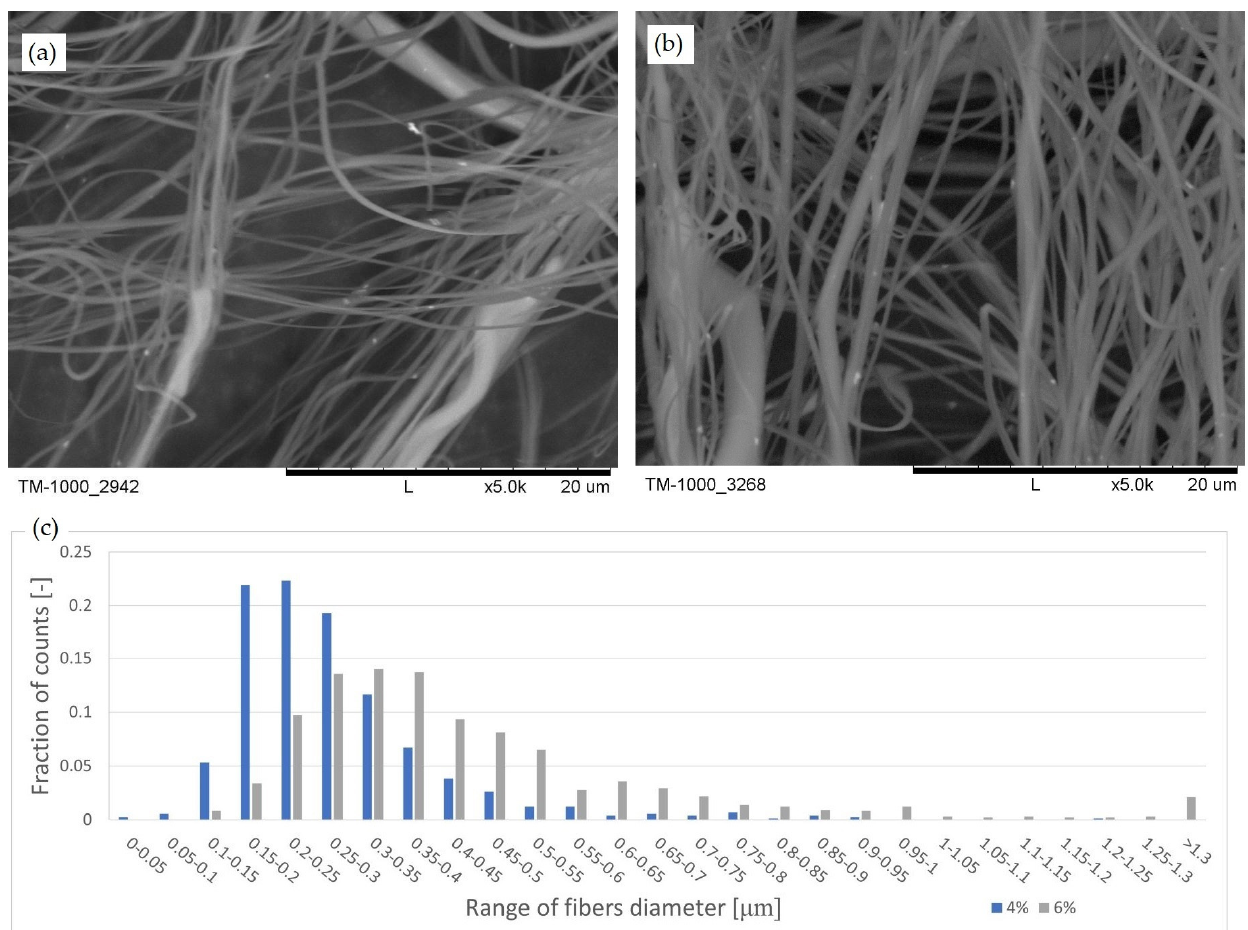
Figure 6. Fibers produced at a flow rate of 0.4 mL/min and air pressure equal to 1 × 10 5 Pa from 4% solution ( a ) and from 6% solution ( b ). Distribution of fibers’ diameters for materials made of 4% and 6% solution ( c ).